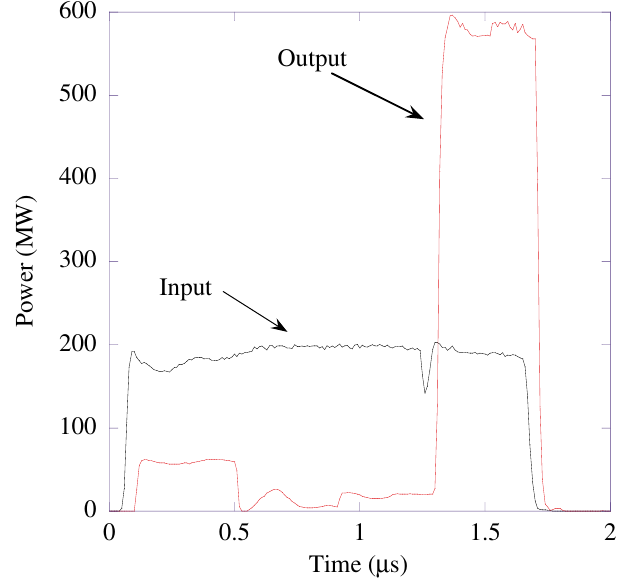
FIG. 24. (Color) System output after processing and without low-level rf corrections (see